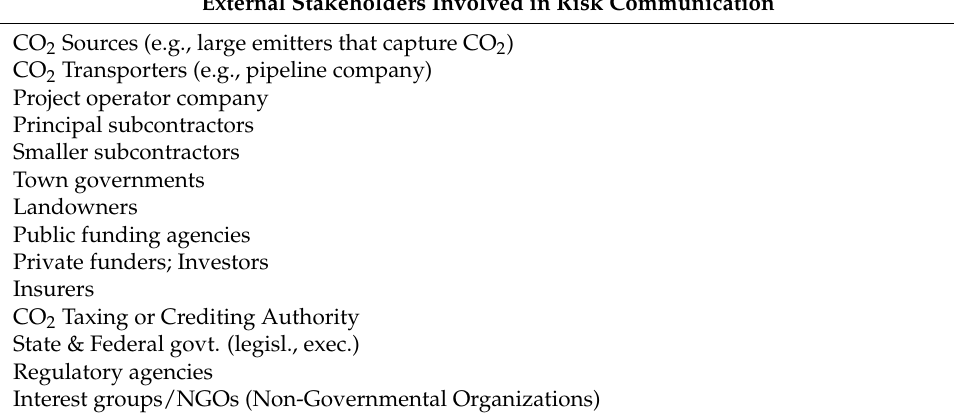
Table 5. List of external